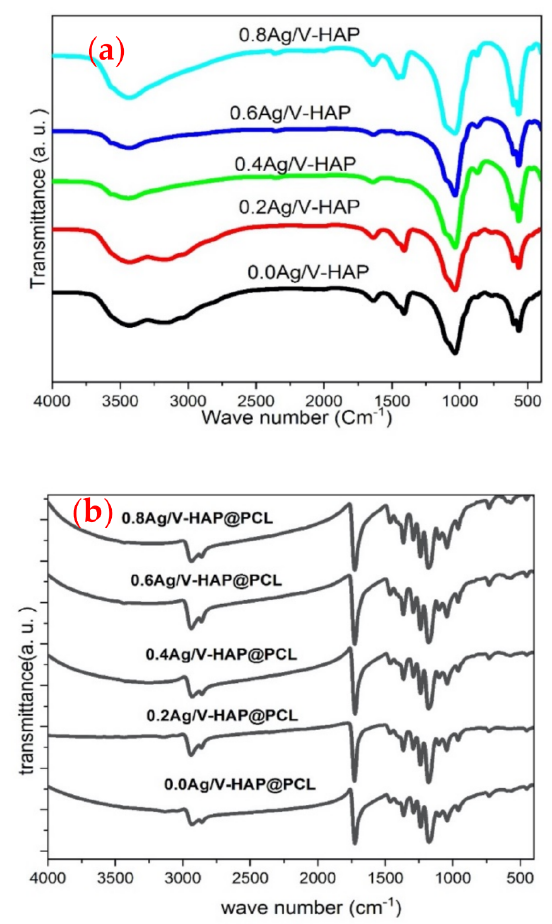
Figure 2. ( a , b ) Fourier Infra Red (FTIR) Spectra of HAP modified with co-doped Ag/V and in- corporated into polycaprolactone: ( a ) Ag/V-HAP in powder phase and ( b ) Ag/V-HAP@PCL in nanofibrous